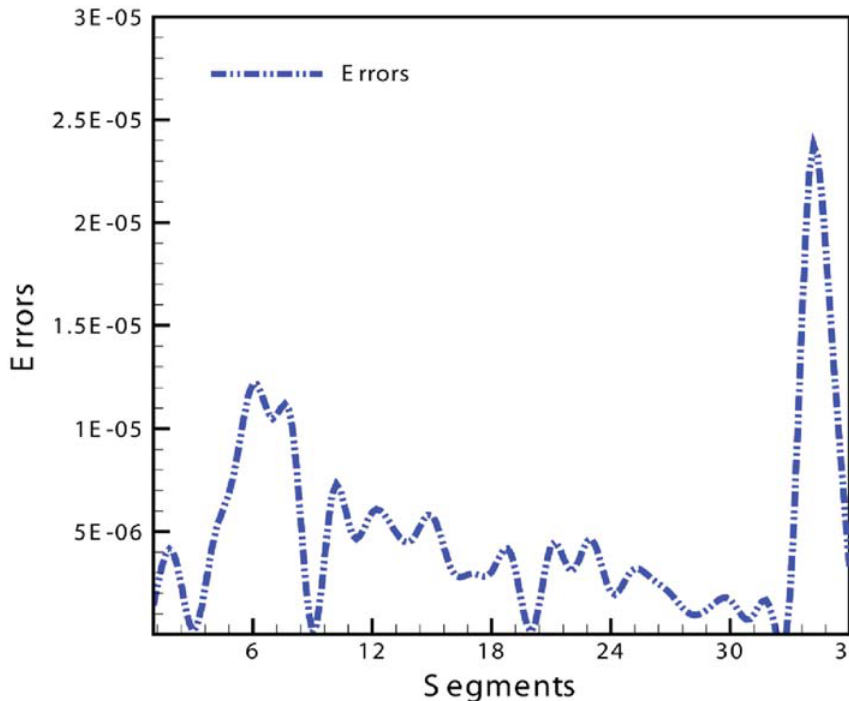
Fig 13. Graph of the normalized mean squares error of slice 176.